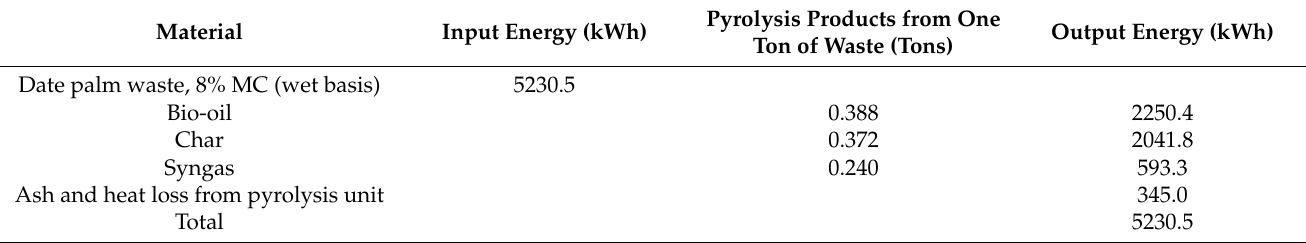
Table 2. Energy balance for processing one ton of date palm waste from fast pyrolysis unit.